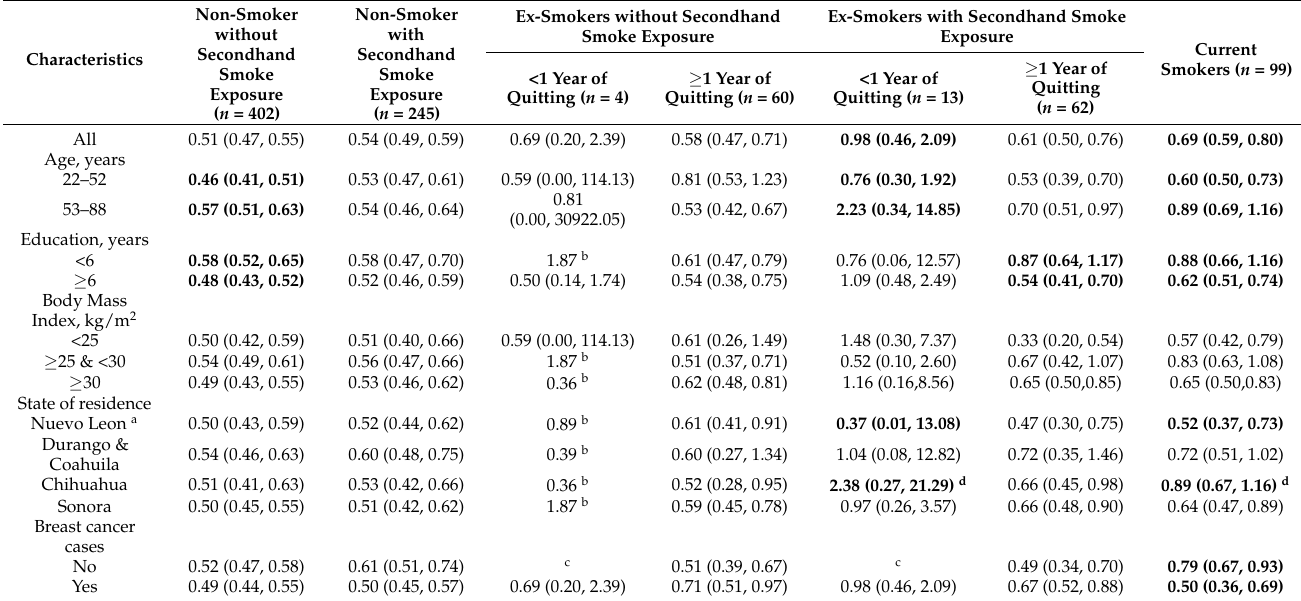
Table 2. Geometric mean urinary cadmium ( µ g/gr-creatinine) (95% CI) concentrations across characteristics of study participants according to self-reported smoke exposure.